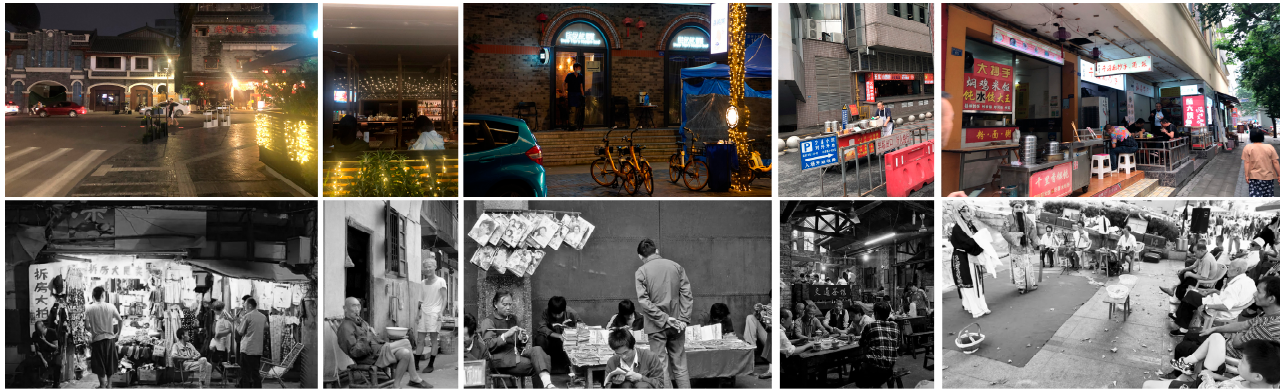
Figure 7. Old and New Comparison Diagram of Scenes of Life in Huaxing Street.